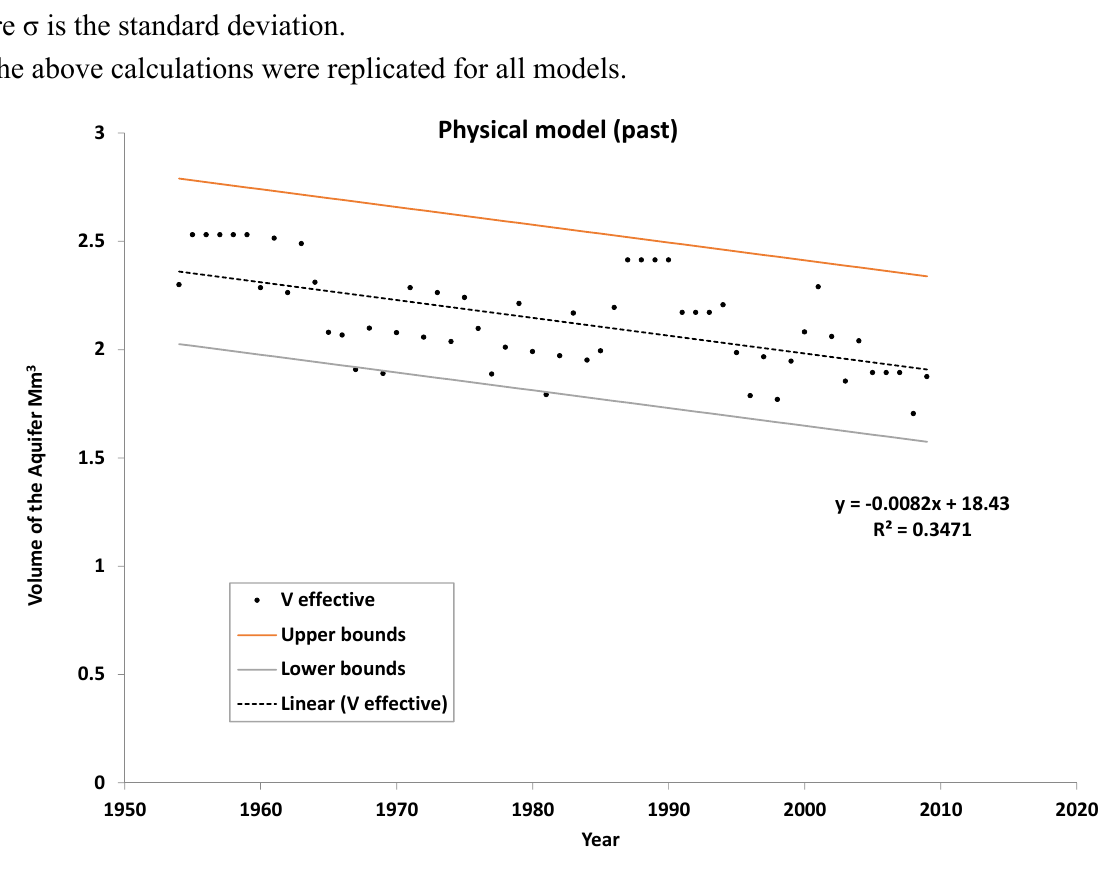
Figure 3. A graphical representation of the physical model based on past data with the uncertainties